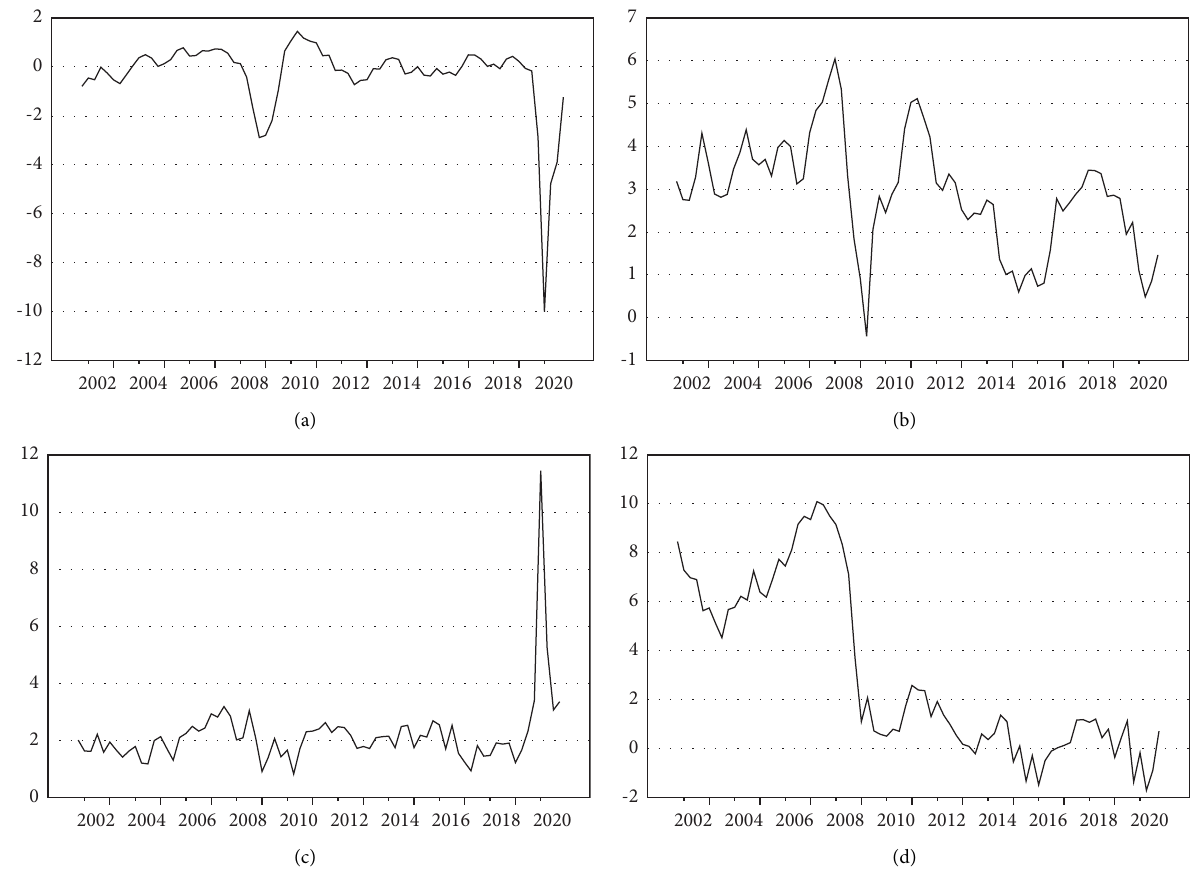
Figure 2: Estimated factors. (a) Foreign real economic factor. (b) Foreign infation factor. (c) Global liquidity factor. (d) World interest rates factor. Note: the unit of the vertical line is %